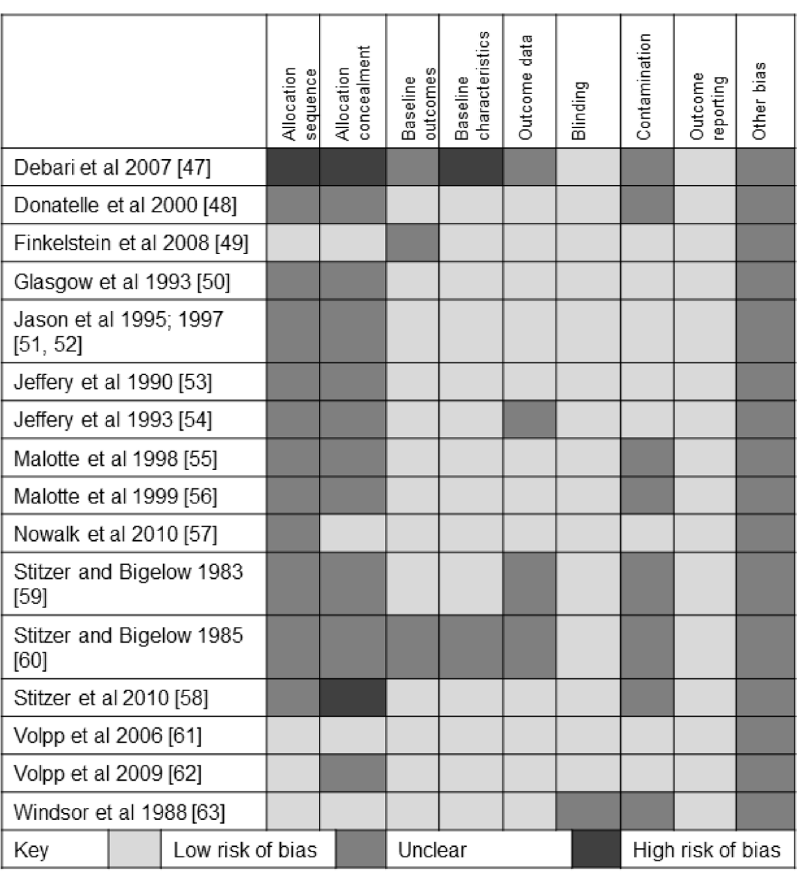
( I 2 = 89%). Sub-group analyses suggested that cash plus other motivational components (RR (95%CI): 2.75 (1.84 to 4.13)) may be more effective than cash or vouchers alone (RR (95%CI): 1.77